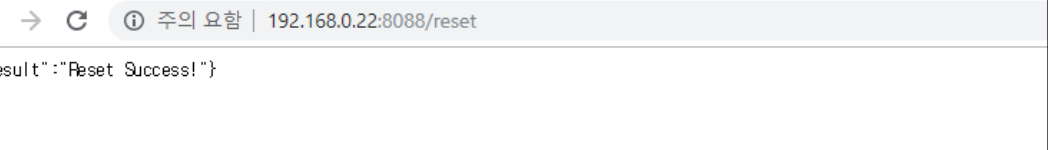
Figure 10. Result of resetting the Kong API gateway using the reset